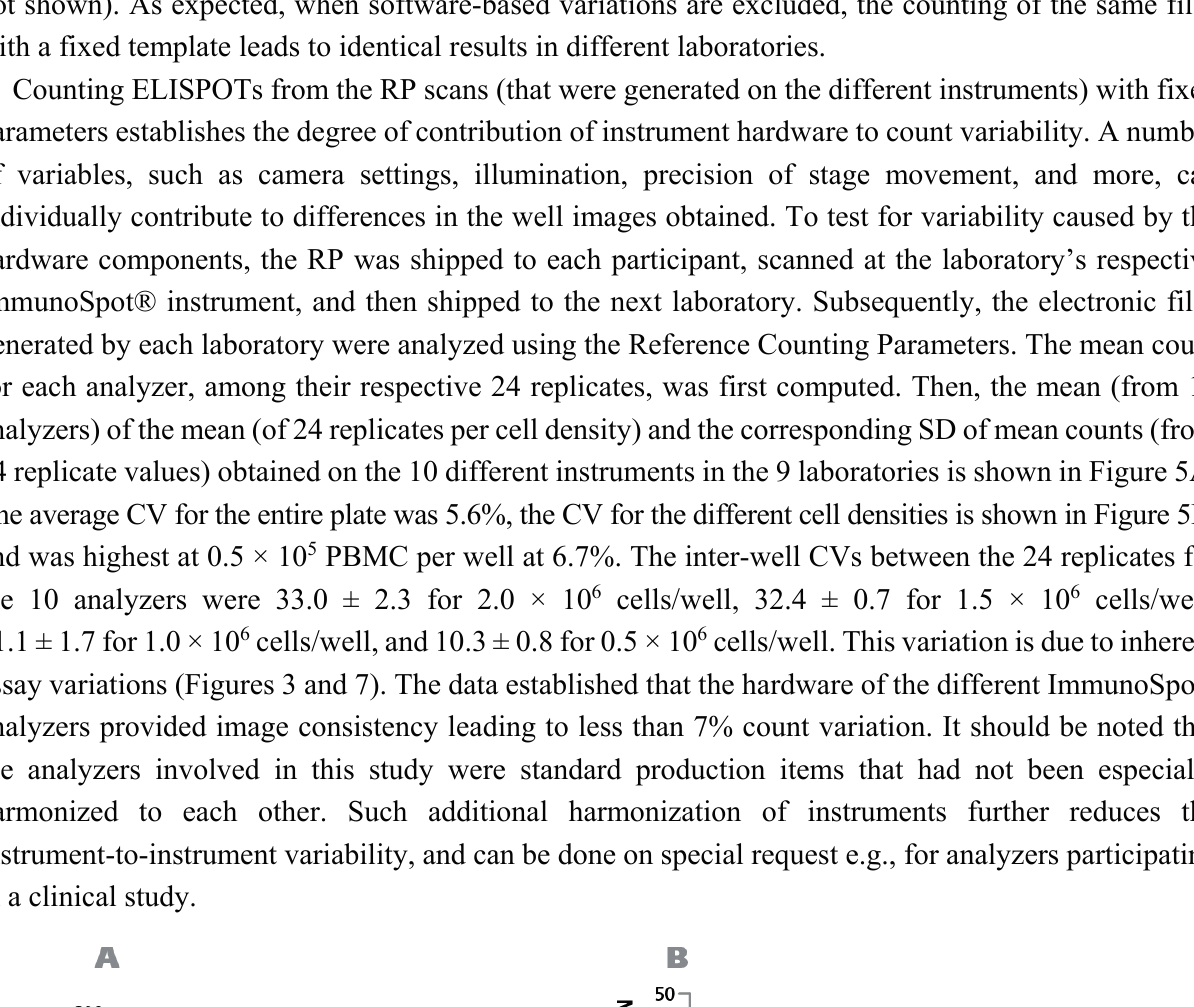
Count™ Mode. ( A ) The mean (from 10 analyzers) of mean (from 24 replicates of each PBMC concentration) and the corresponding SD is shown with the average CV for the entire plate, ( B ) the CV is shown for the four cell